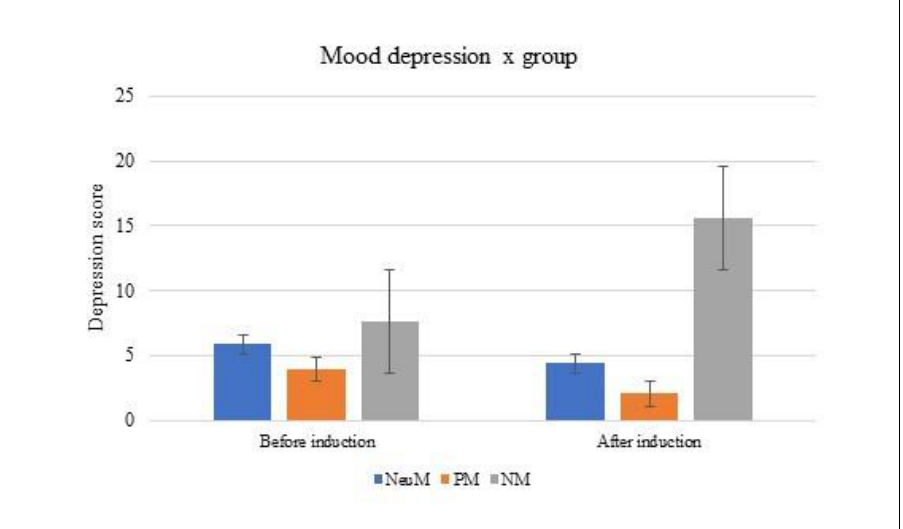
Figure 2. Rating of the ‘depression’ sub -score of the POMS before and after mood induction, with respect to positive, negative and neutral music groups. The error bars represent the standard errors of the means .